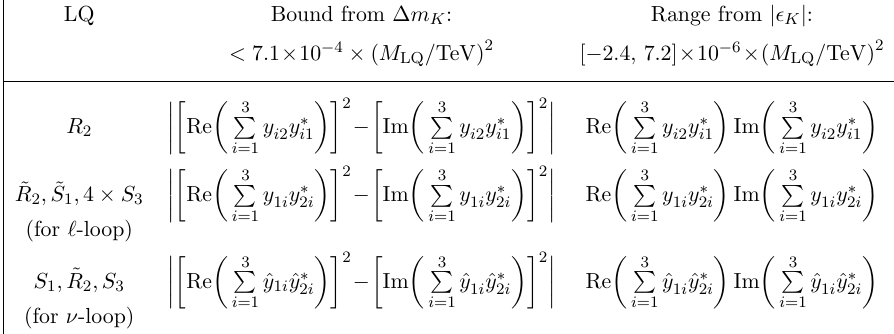
Table 11 . Bounds on leptoquark couplings from neutral kaon